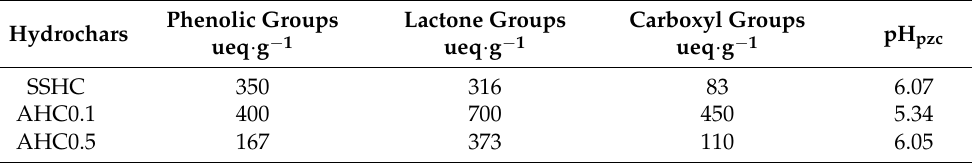
Table 2. Content of oxygen-containing groups and pH pzc of SS-derived hydrochars.